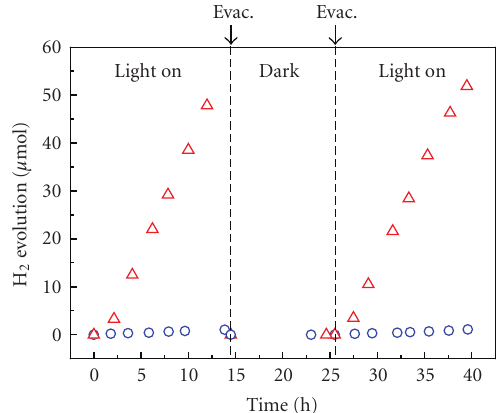
Figure 8: Photocatalytic water splitting from pure H 2 O on NiO/La 1 / 3 MO 3 (M = Nb, Ta) photocatalysts (0.8wt% NiO, 0.5 g photocatalyst, 400 ml H 2 O) under UV light irradiation. Light source: a 400 W high-pressure Hg lamp. ◦ : La 1 / 3 NbO 3 ; (cid:2) : La 1 / 3 TaO 3